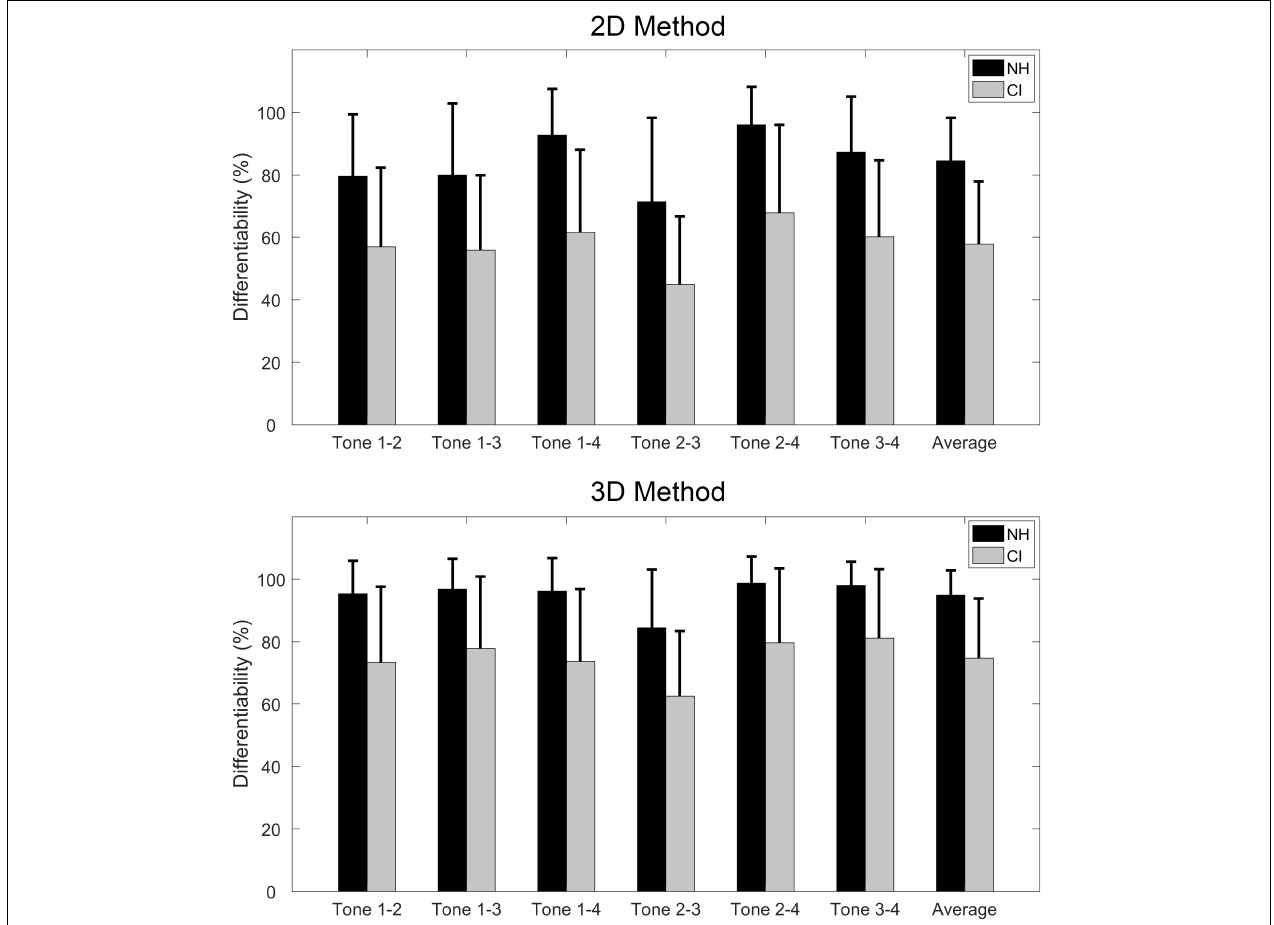
FIGURE 3 | Tone differentiability of the six tone contrasts, as well as the average differentiability, based on the 2D method (upper panel) and 3D method (lower panel) . Black and gray bars represent the NH and CI groups, respectively. The error bars stand for 1 standard deviation.